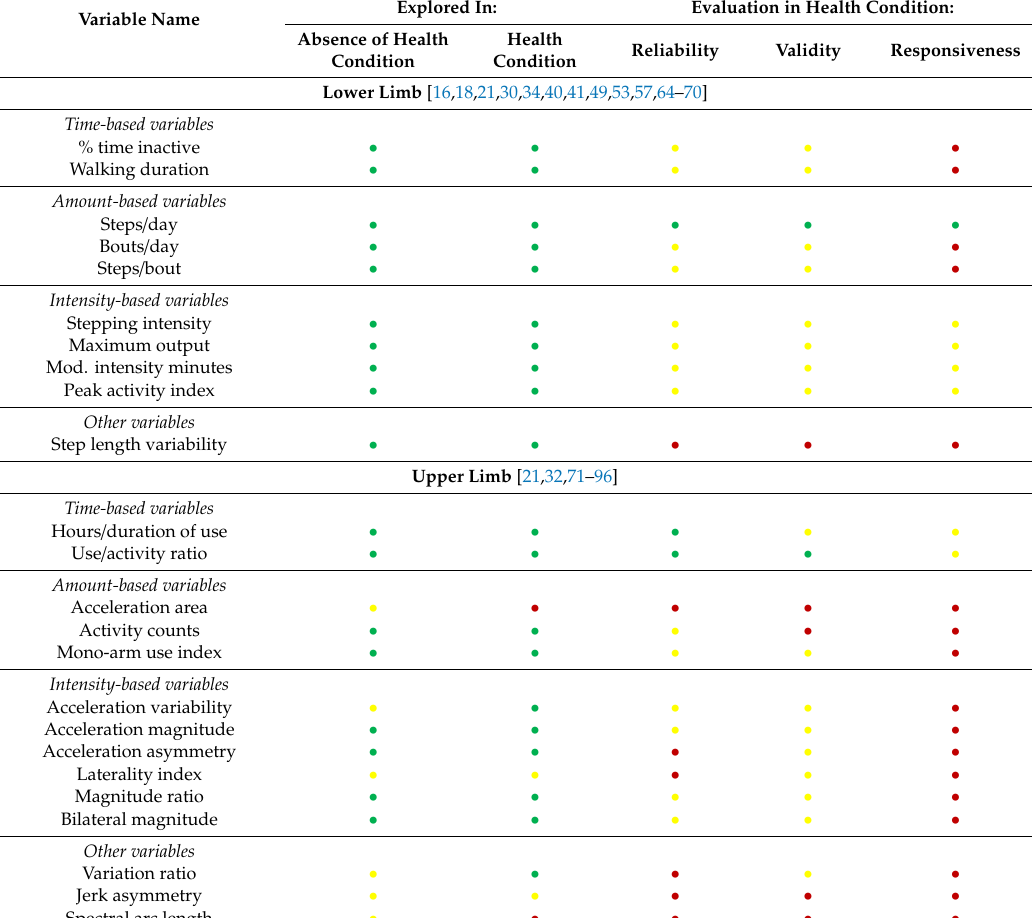
Table 1. A sample of wearable-derived variables proposed in the literature. This list is not exhaustive, withnewvariablesproposedallthetime. Publishedvariabledatahavebeenjudgedas: Green = su ffi cient data for implementation into clinical practice; Yellow = some data available to-date, but not yet su ffi cient for implementation; and Red = no data